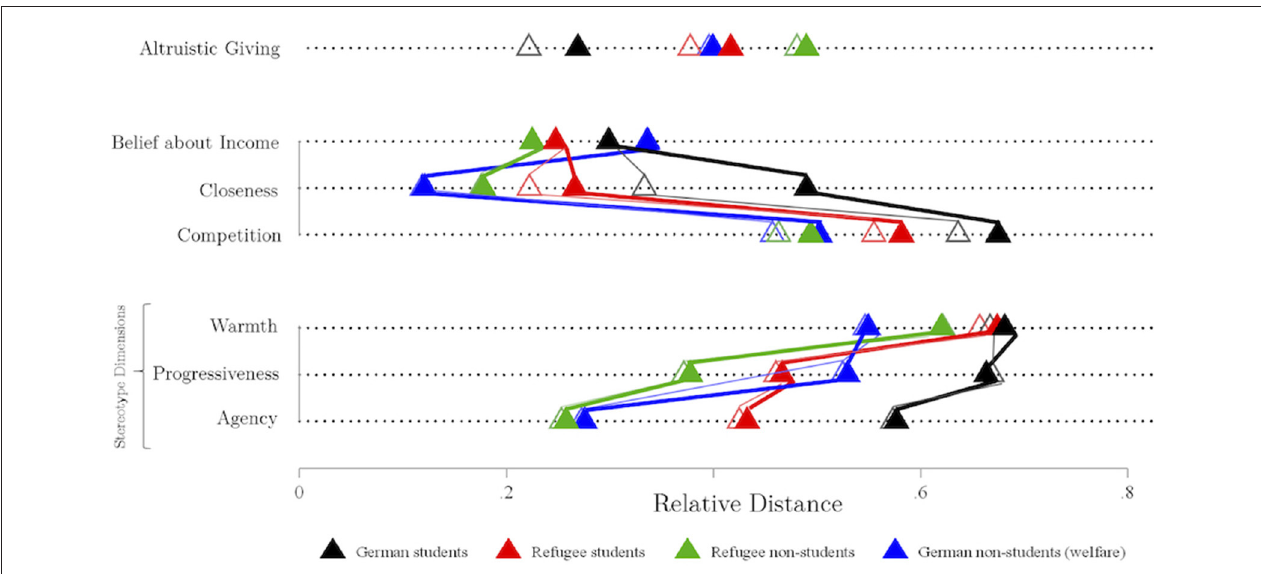
FIGURE 3 | Graphical illustration of the relative distance between the individual receiver groups [German students, non-student Germans ( = social welfare recipients), refugee students and non-student refugees] on predictors (belief about income, perceived closeness, competition, warmth, progressiveness, and agency) and altruistic giving. Relative distance was calculated as DG giving – min DG giving to all groups/(min DG giving to all groups – max DG giving to all groups). Full symbols mark local and hollow symbols mark non-local